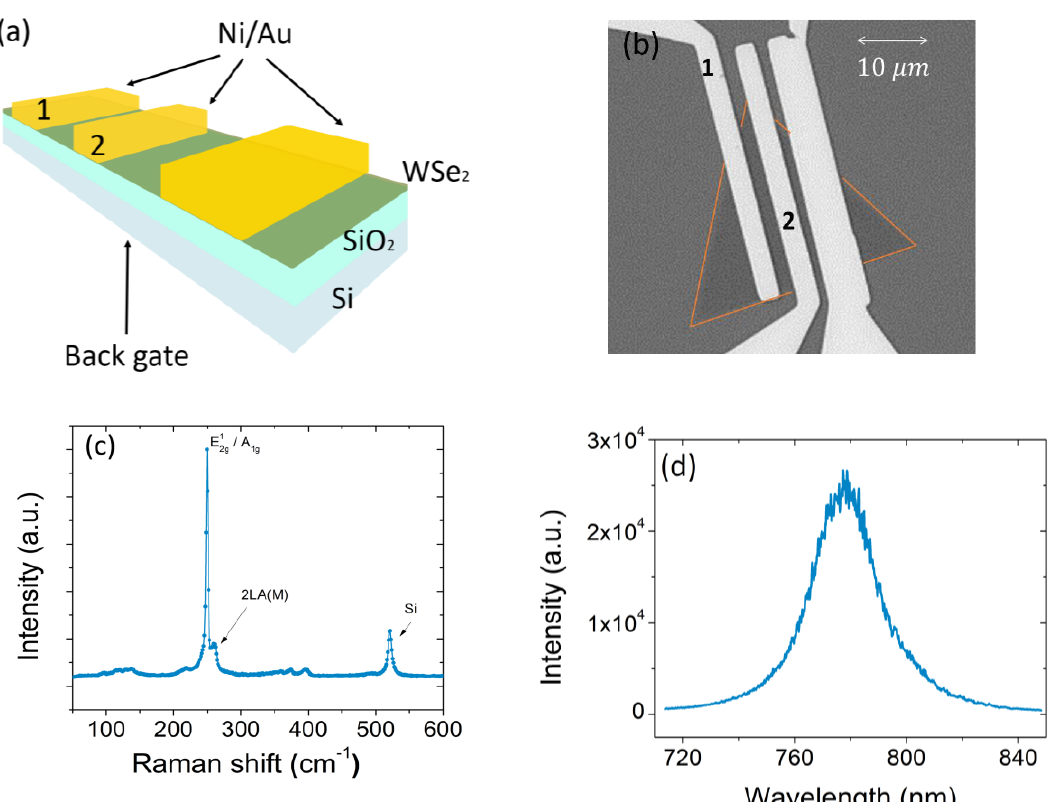
Figure 1. Schematic diagram ( a ) and optical microscope image ( b ) of the WSe 2 back gate FET transistor. Raman ( c ) and photoluminescence ( d ) spectra of the WSe 2 flake.